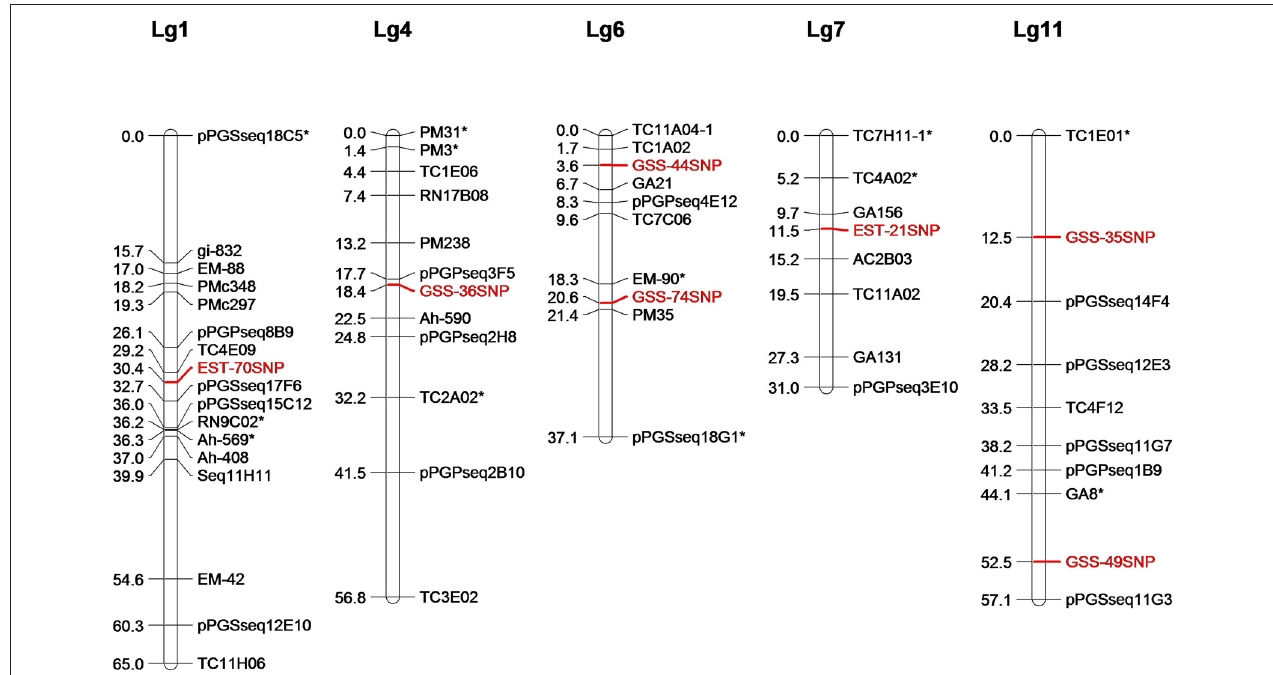
FIGURE 5 | Location of seven SNPs markers on LGs of RIL population Y13Zh. Seven SNPs markers were mapped into five linkage groups of RIL population Y13Zh, which were showed in red. * Indicates distorted marker